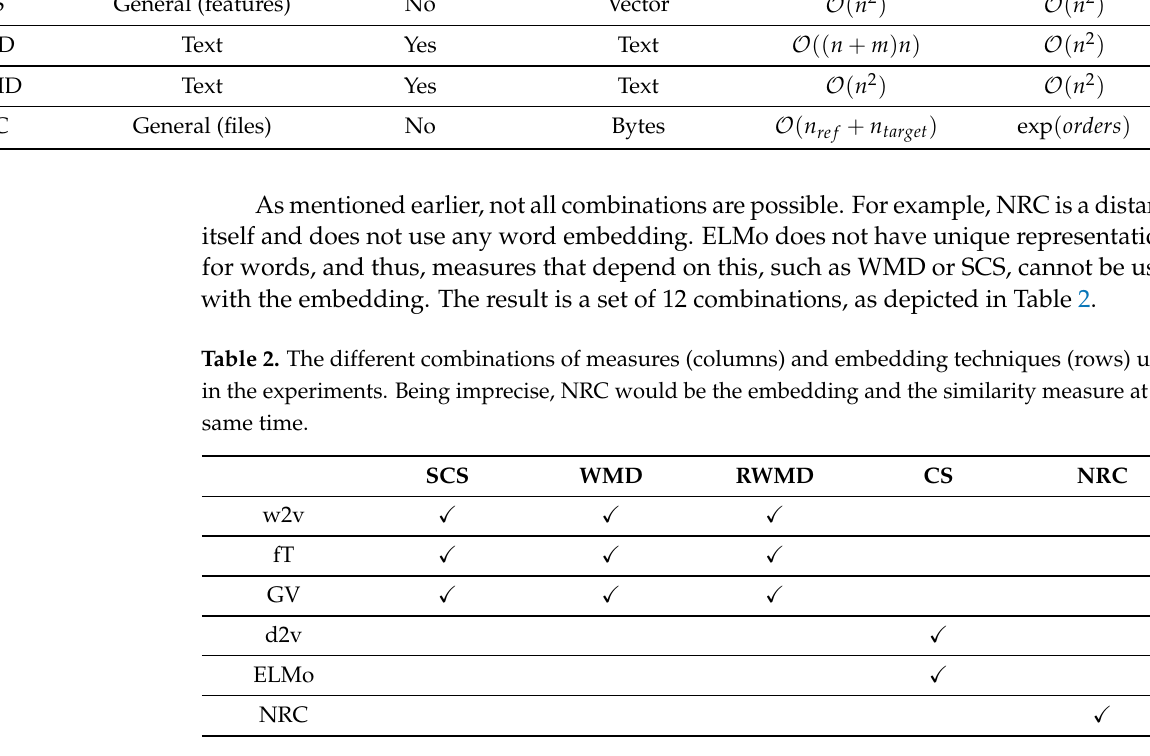
Table 1. Summary of the evaluated similarity measures with their complexity. Most of the techniques have an acceptable cost except, probably, WMD, which is very slow. Regarding memory, again,